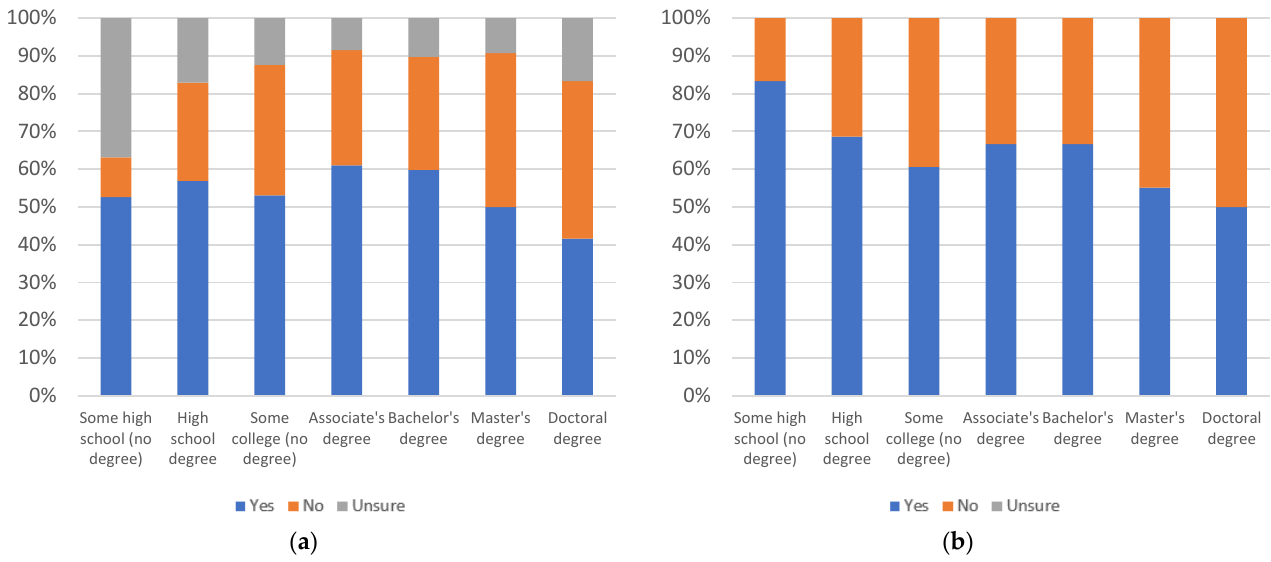
Figure 92. Label use, by education level: ( a ) with uncertain respondents (left) and ( b ) without uncertain respondents (right).